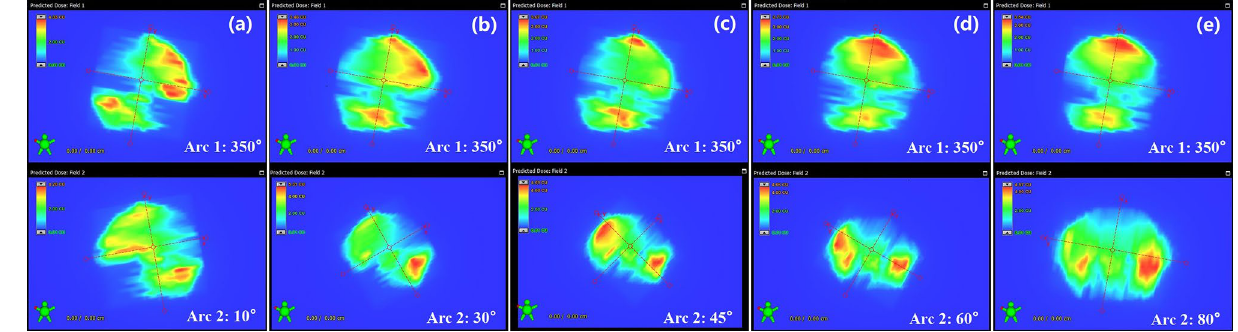
Figure 1. Predicted dose distribution for each arc of dual-arc VMAT plans in coronal view with collimator settings of ( a ) 350°/10°, ( b ) 350°/30°, ( c ) 350°/45°, ( d ) 350°/60°, and ( e ) 350°/80° for a typical patient.